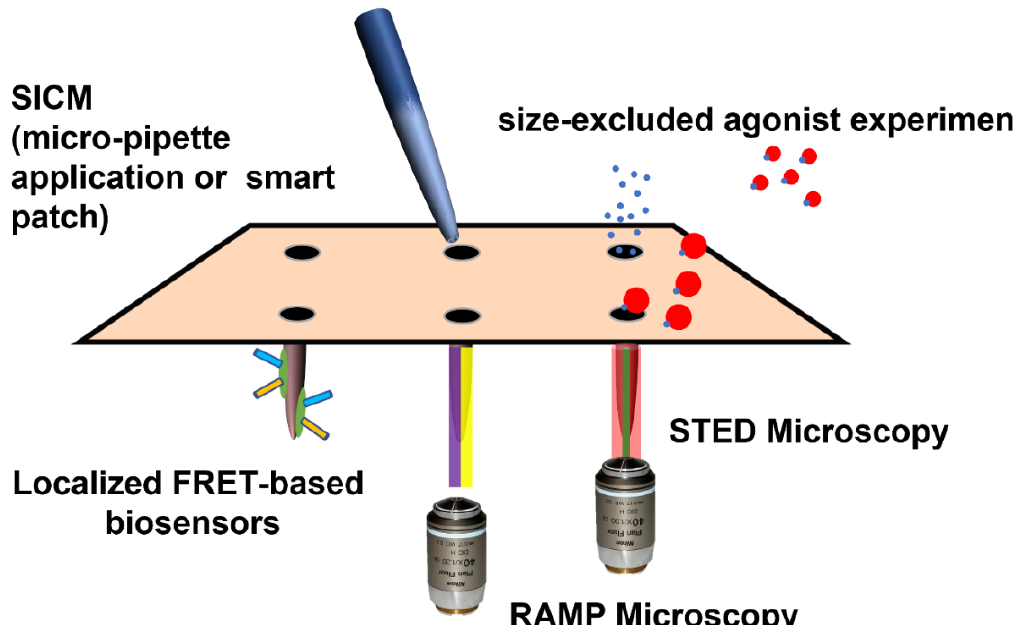
Figure 3. Existing experimental modalities with t-tubular resolution, permitting analysis of βAR physiology.